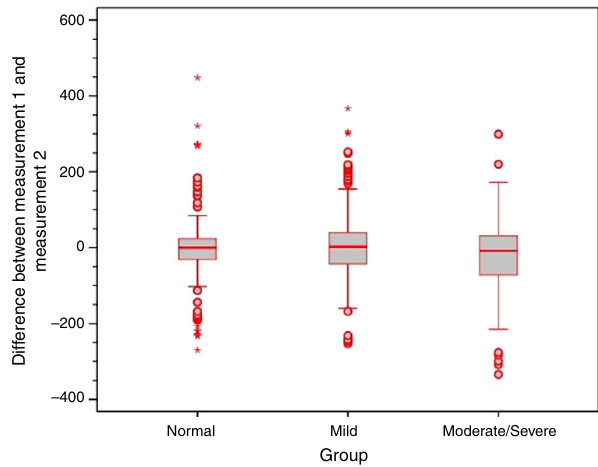
Figure 4 Box plot of differences between time points 1 and 2 for the Valsalva maneuver in the three study groups.